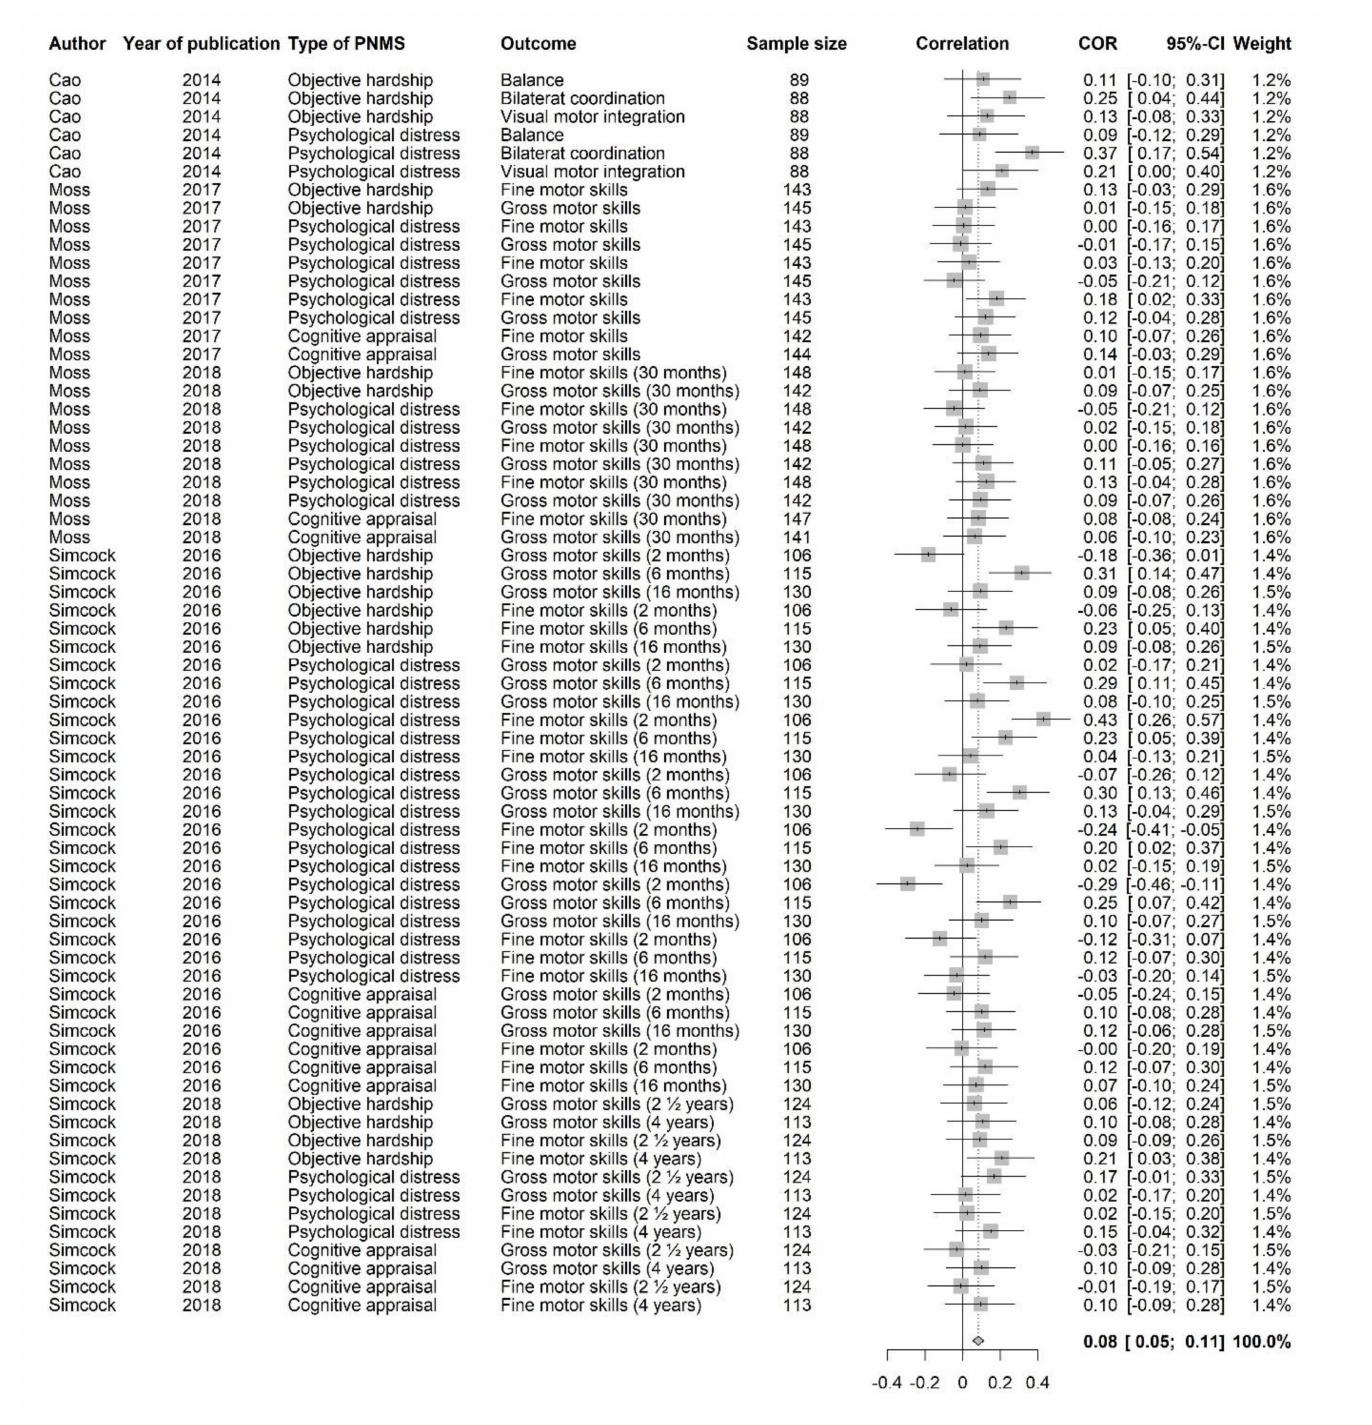
Figure 8. Motor outcomes forest